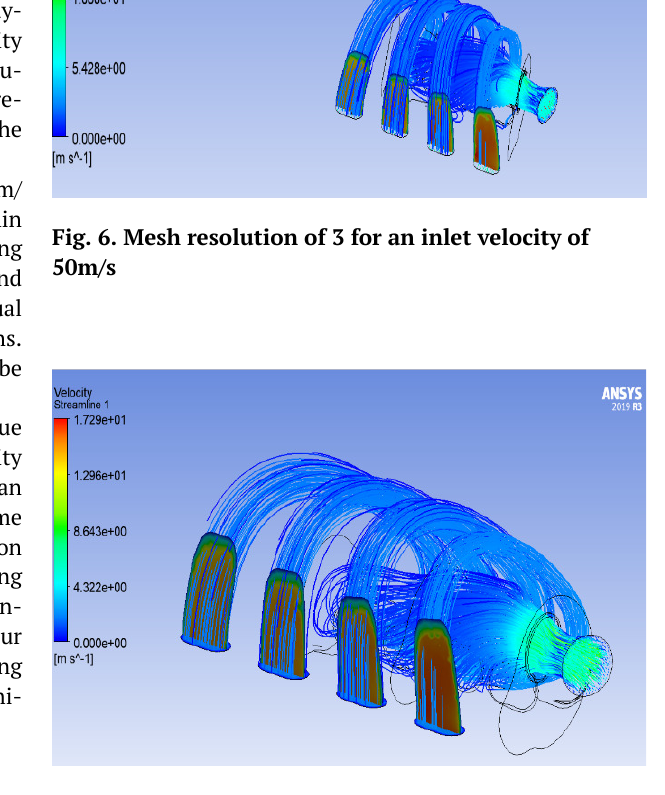
Fig. 7. Mesh resolution of 7 for an inlet velocity of 50